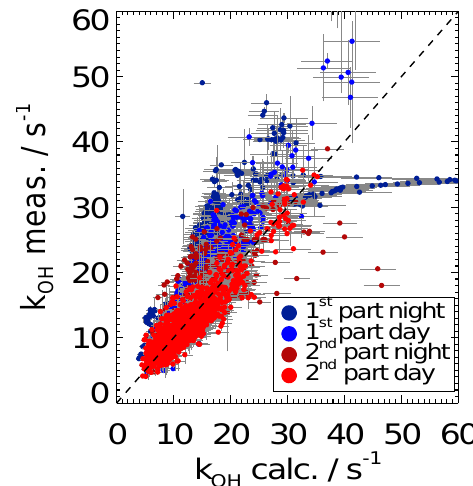
Figure 7. Correlation between calculated and measured OH reactiv- ity with color-coded periods. The linear correlation coefficient ( R 2 ) is 0.77 for the entire data set and data from both periods